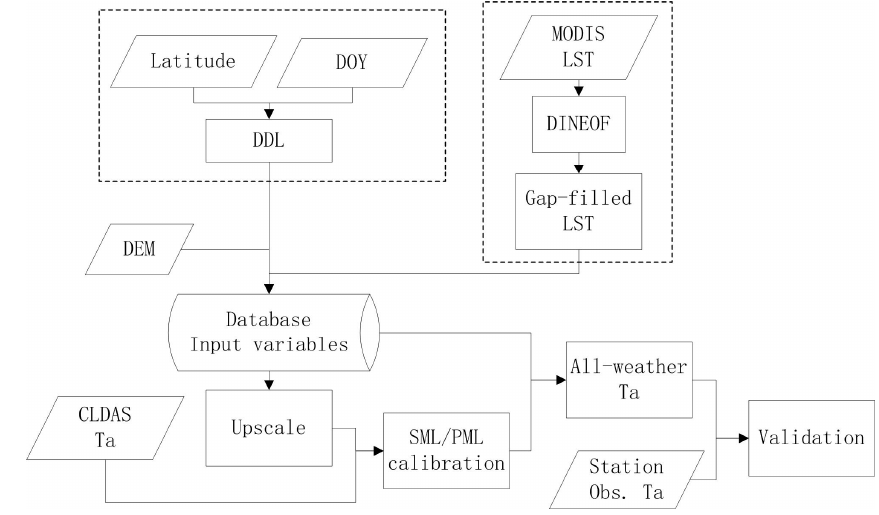
Figure 2. Flow chart of the Ta estimation scheme.